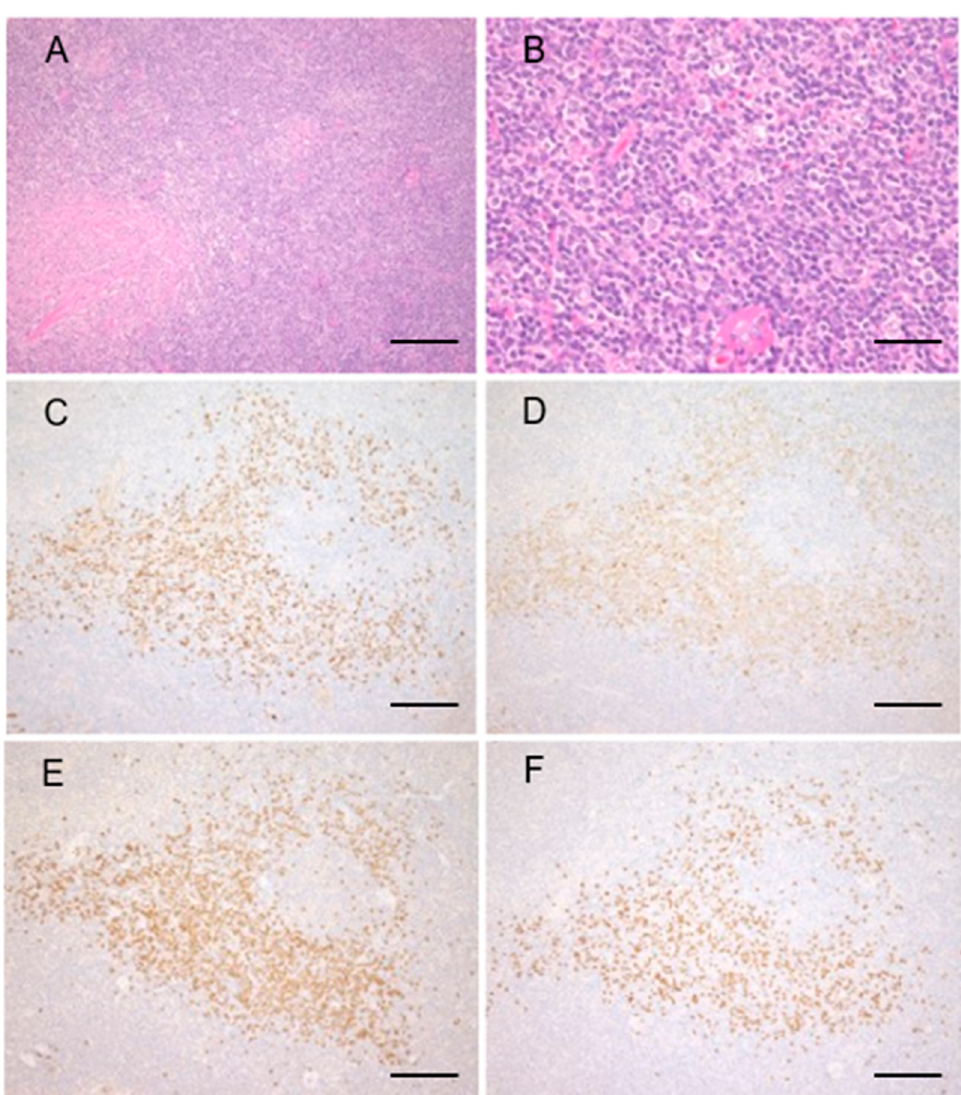
Figure 2. Marginal zone lymphoma with IgG4-positive cells. Representative pathological images of marginal zone lymphoma with IgG4-positive cells. The interfollicular expansion and diffusely proliferating atypical lymphoid cells with mild fibrosis ( A , B ) Infiltration of many IgG+ ( C ) and IgG4+ ( D ) cells are observed. The IgG4+/IgG+ cell ratio is >80%. Infiltrating B cells had no light chain restrictions; Ig κ -ISH ( E ) and Ig λ -ISH ( F ). Scale bar; ( A ): 200 µm, ( B ): 50µm, ( C – F ): 200 µm.